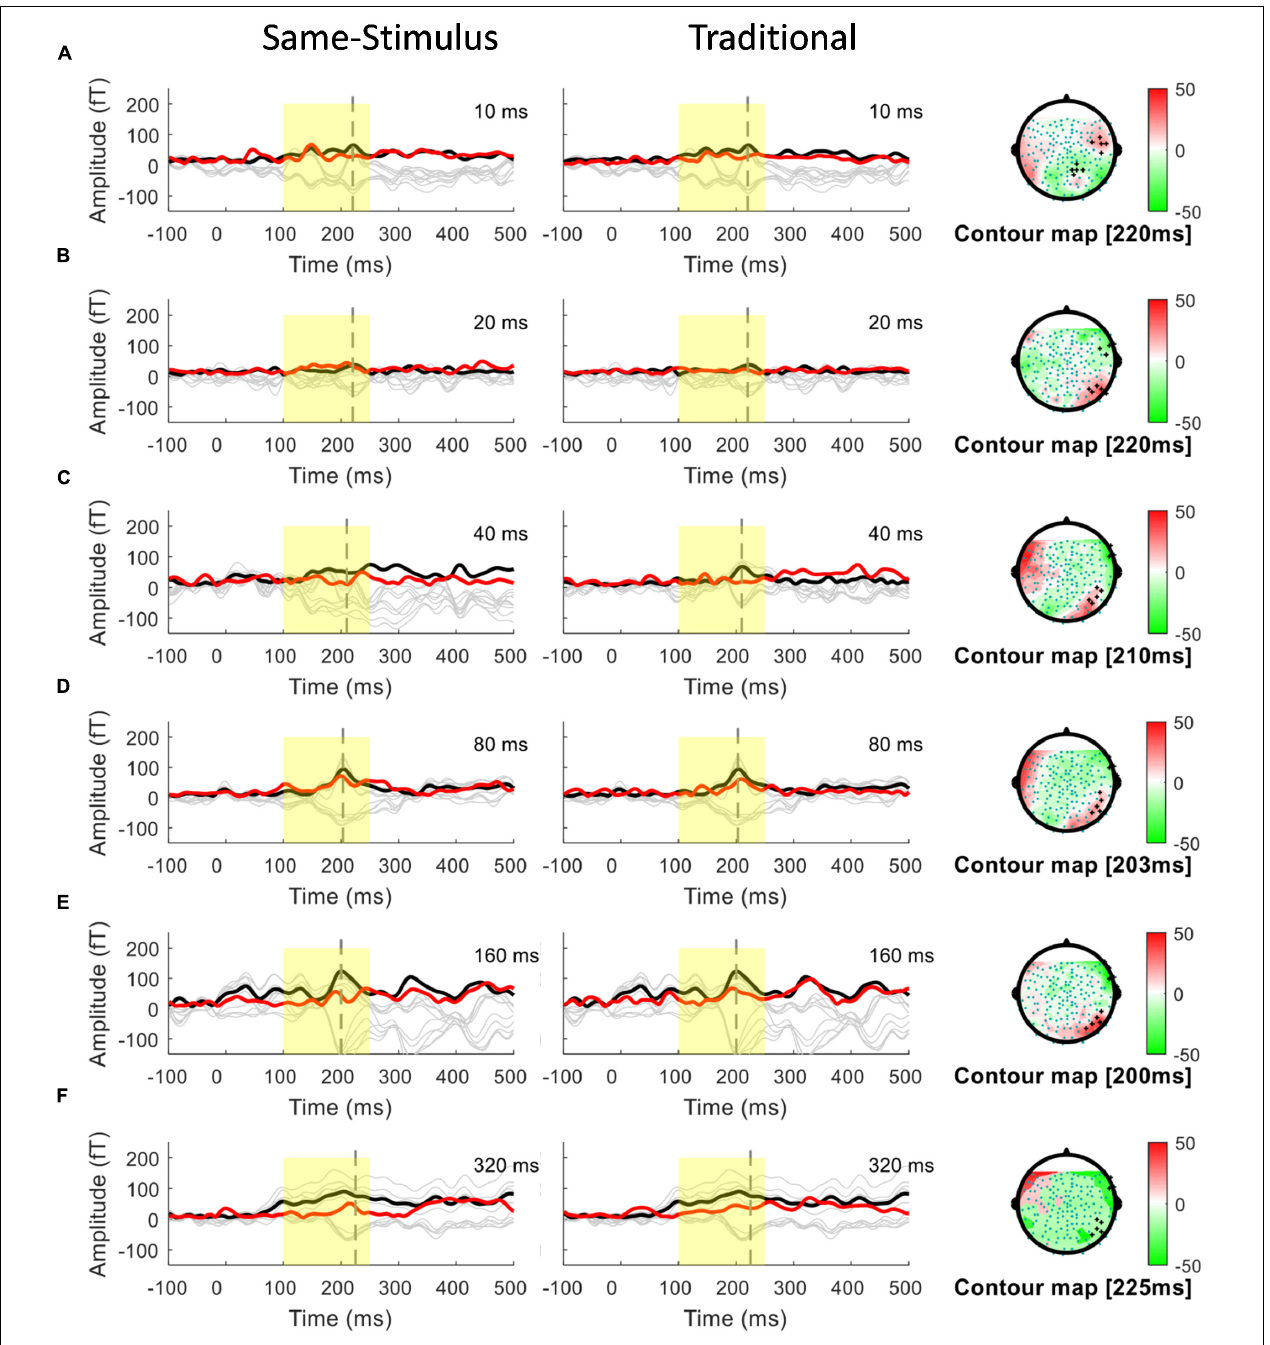
FIGURE 3 | Overlays of average standard (red line) and deviant (black line) magnetic field waveforms from a representative participant for each upward FM-sweep duration condition in the right hemisphere. The red lines are the RMS of the standard waveforms that were measured from the 10 selected sensors that showed the field patterns of MMNm. The topographical maps (right) show the differential activities of the mismatched waveforms corresponding to each sweep condition. MMNm response is elicited similarly using the same-stimulus (left) and traditional (middle) methods. Standard and deviant waveforms elicited by (A) 10-ms sweep (B) 20-ms sweep (C) 40-ms sweep (D) 80-ms sweep (E) 160-ms sweep (F) 320-ms sweep.